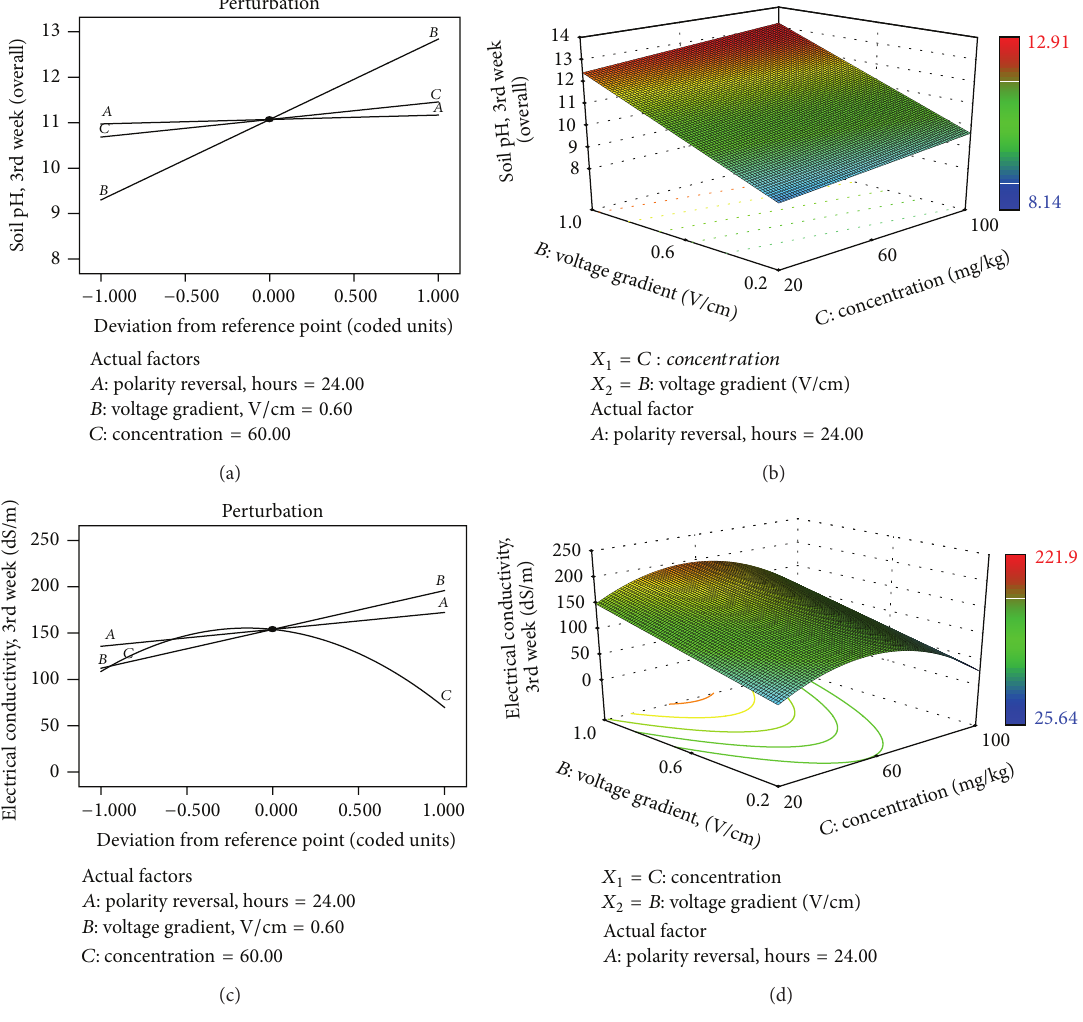
Figure 6: Perturbation plots showing the relative significance of factors on soil pH (a) and electrical conductivity (c) (left). 3D response surface and contour plots showing how the influential factors affect soil pH (b) and electrical conductivity (d)